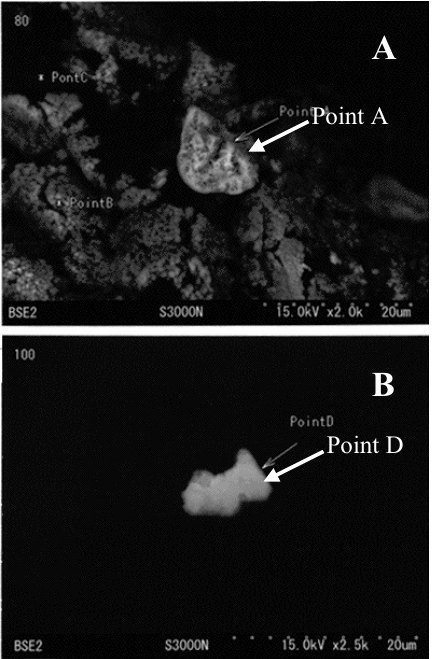
Fig. 4. – Scanning electron microscope (SEM) images of crystals observed in complexes of chlorophyll with low molecular weight proteins present in the 80 % (A) and 100 % (B) acetone-soluble frac- tions. By using an SEM/energy dispersive X-ray (EDX) analyzer, Fe atoms were detected at point A (A) and S and Mo atoms were detected at point D (B).